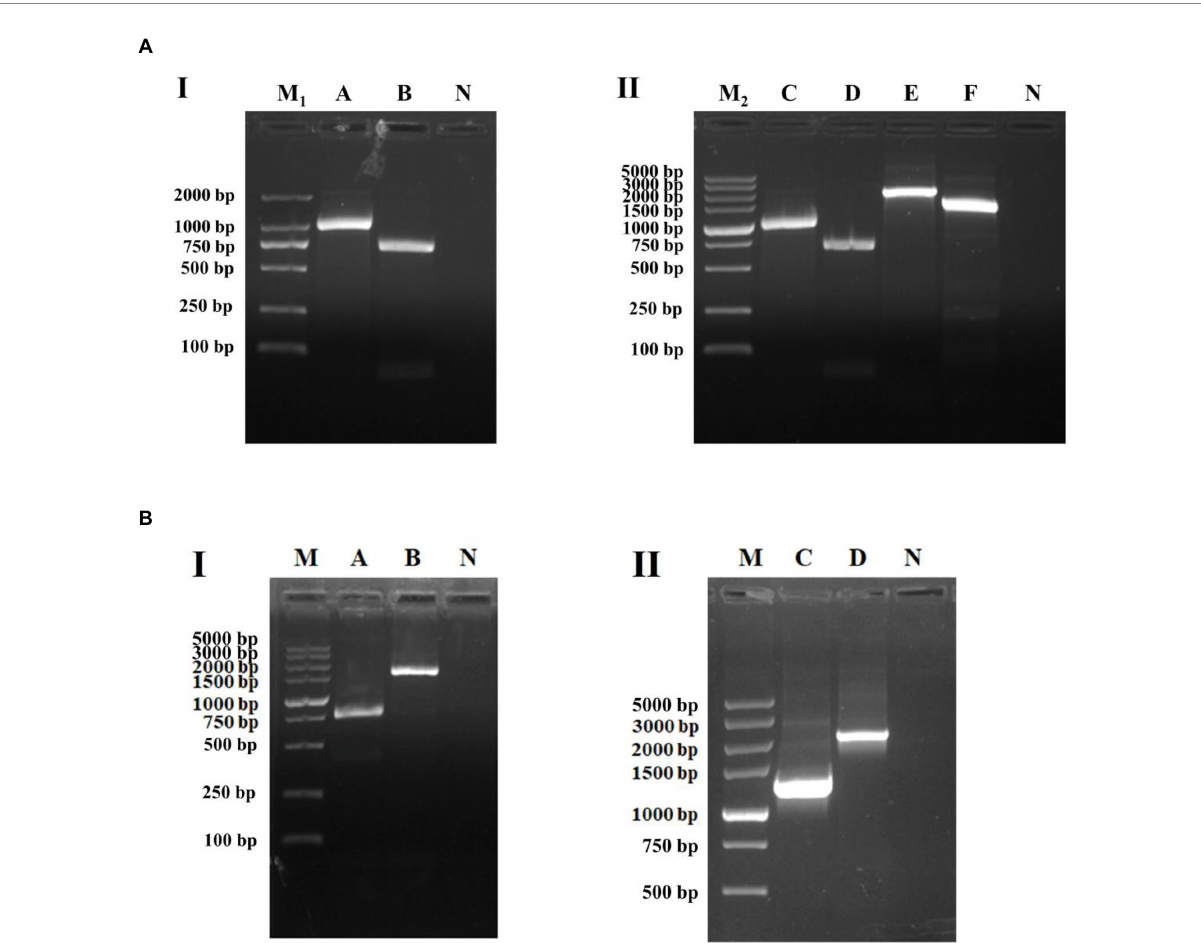
FIGURE 4 Identification of PCR amplification products (A) and integration (B) . I: Identification of pUCINTI1 and pUCINTI15 by PCR. M 1 , DL2000 DNA Marker; A, intI1 (1,033 bp); B, intI1-15 (717 bp); N, control; II, identification of pUCINTI1, pUCINTI15 and pACINT, pACINT15 by PCR. M 2 , DL5000 DNA Marker; C, intI1 (1,033 bp); D, intI1-15 (717 bp); E, INT (2,330 bp); F, INT15 (1,526 bp); N, control. I, identification of integration function of intI1 . II, identification of integration function of intI1-15 . M, DL5000 DNA Marker; A, before integrated (779 bp); B, after integrated (1,634 bp); C, before integrated (1,268 bp); D, after integrated (2,123 bp); N,